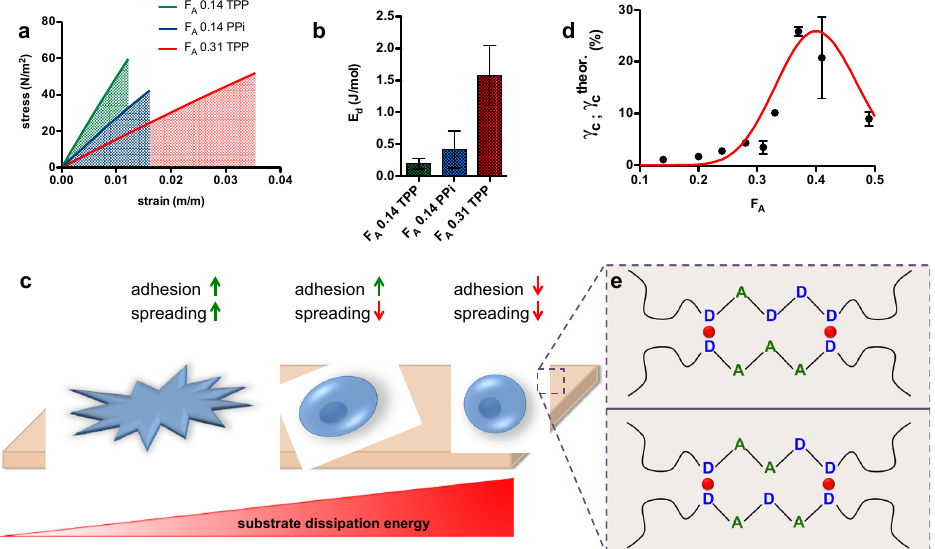
Figure 13. Substrate dissipation energy as novel cell controller. ( a ) Stress as a function of strain for different chitosan substrates. ( b ) Energy at different fractions of acetylation (F A ). ( c ) How the substrate dissipated energy controls adhesion and spreading. ( d ) Critical strain as a function of F A . ( e ) Scheme showing how chitosan substrate allow two possible combinations of five consecutive monomers (pentads) irrespective of sugar position behave as “energy dampers” thus dissipating shear forces (A = N-acetyl-glucosamine unit, D = glucosamine unit). Reproduced from [209] with permission of John Wiley and Sons.